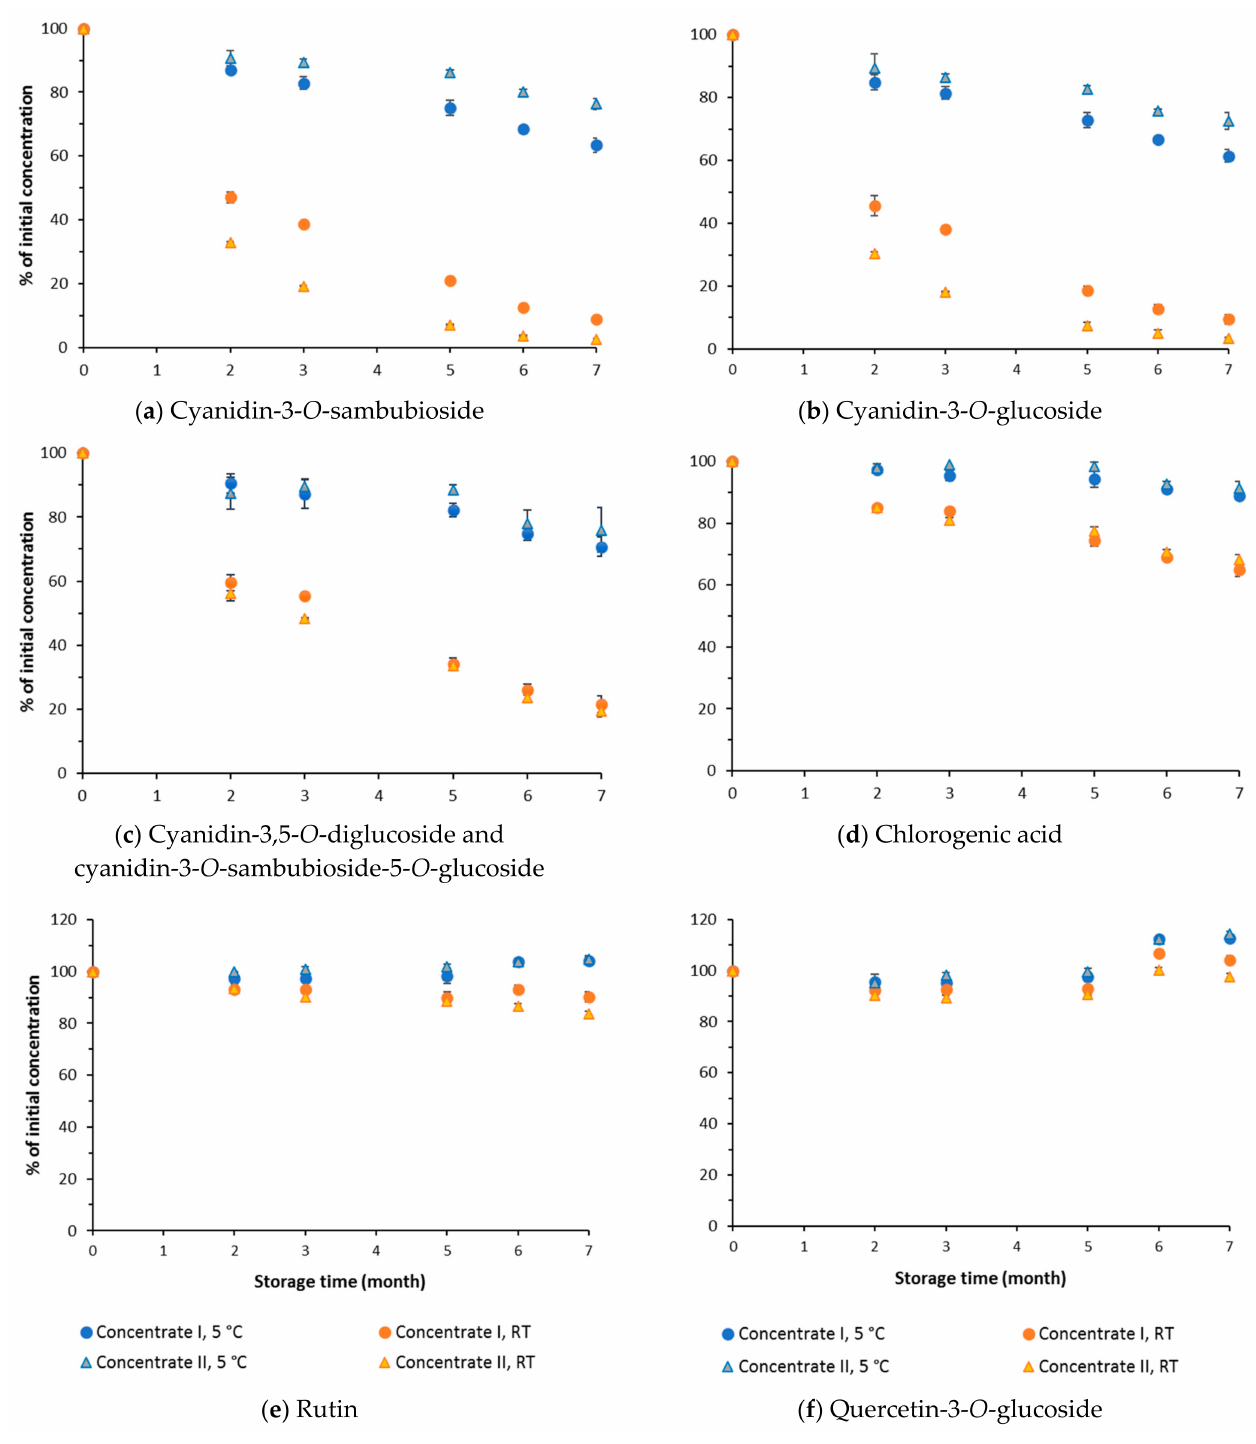
Figure 4. Changes in ( a ) cyanidin-3- O -sambubioside, ( b ) cyanidin-3- O -glucoside, ( c ) cyanidin-3,5- O -diglucoside + cyanidin- 3- O -sambubioside-5- O -glucoside, ( d ) chlorogenic acid, ( e ) rutin, and ( f ) quercetin-3- O -glucoside of elderberry concentrates I and II during storage at 5 ◦ C and at room temperature